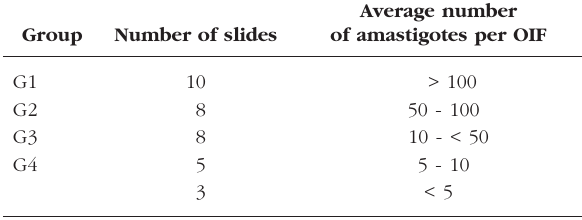
based on clinical symptoms can be problematic, since several species cause both visceral and cutaneous disease (Rhajaoui, 2010; Schönian et al. , 2003). Thus, as symptoms can vary and may be confused with